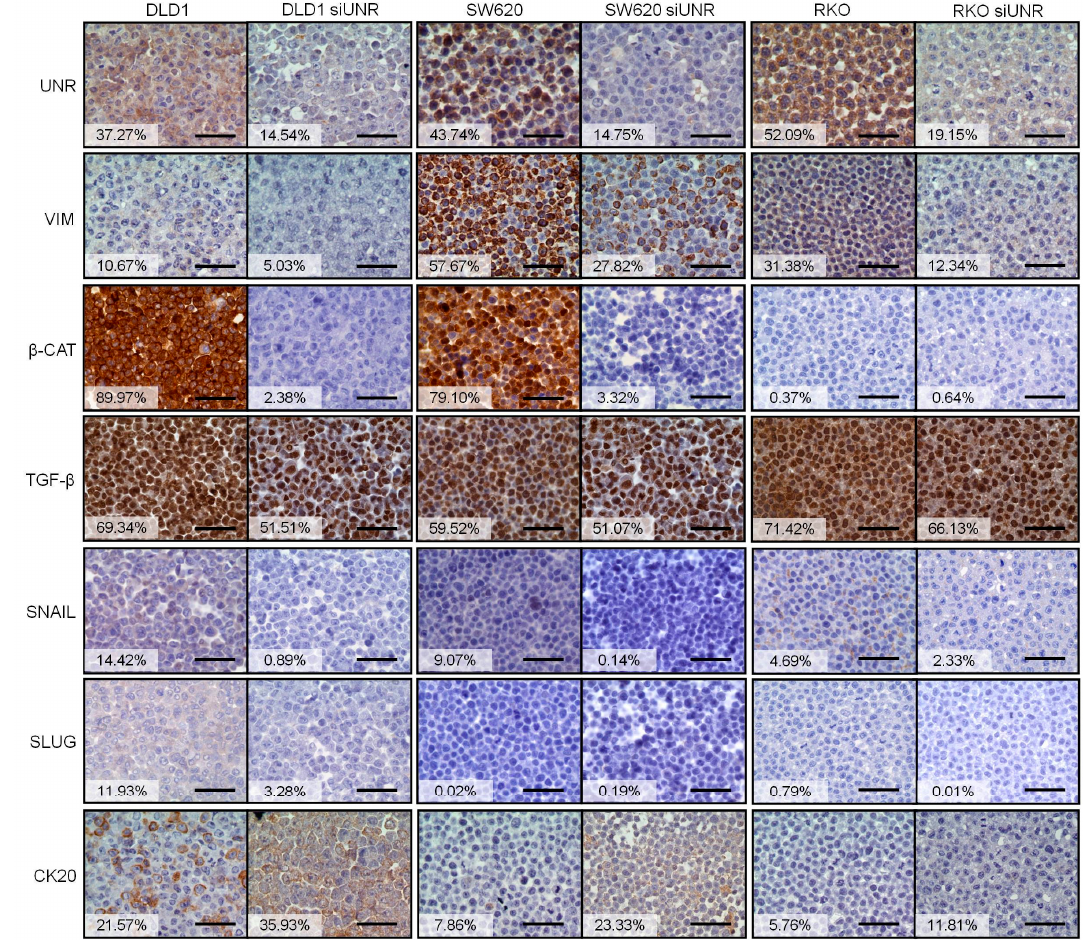
Figure 3. UNR is critical for the maintenance of epithelial-to-mesenchymal transition. Immunohistochemical staining for the expression of UNR, vimentin (VIM), β -catenin ( β -CAT), TGF- β , snail, slug, and cytokeratin 20 (CK20) in DLD1, SW620, and RKO CRC derived cell lines before and after UNR / CSDE1 downregulation. Vimentin (VIM), β -catenin ( β -CAT), TGF- β , snail, and slug decreased their expression after UNR downregulation, while Cytokeratin 20 (CK20) expression increased after UNR downregulation. Cells were stained 48 h after UNR downregulation. Percentages of DAB staining for each CRC derived cell line are reflected in the white boxes. Scale bars represent 500 μ m.